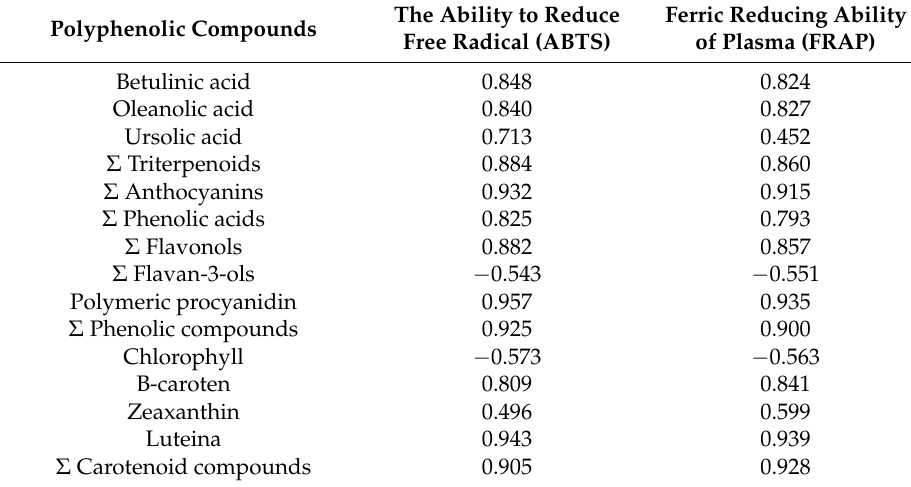
Table 4. Correlation between antioxidant activity and bioactive